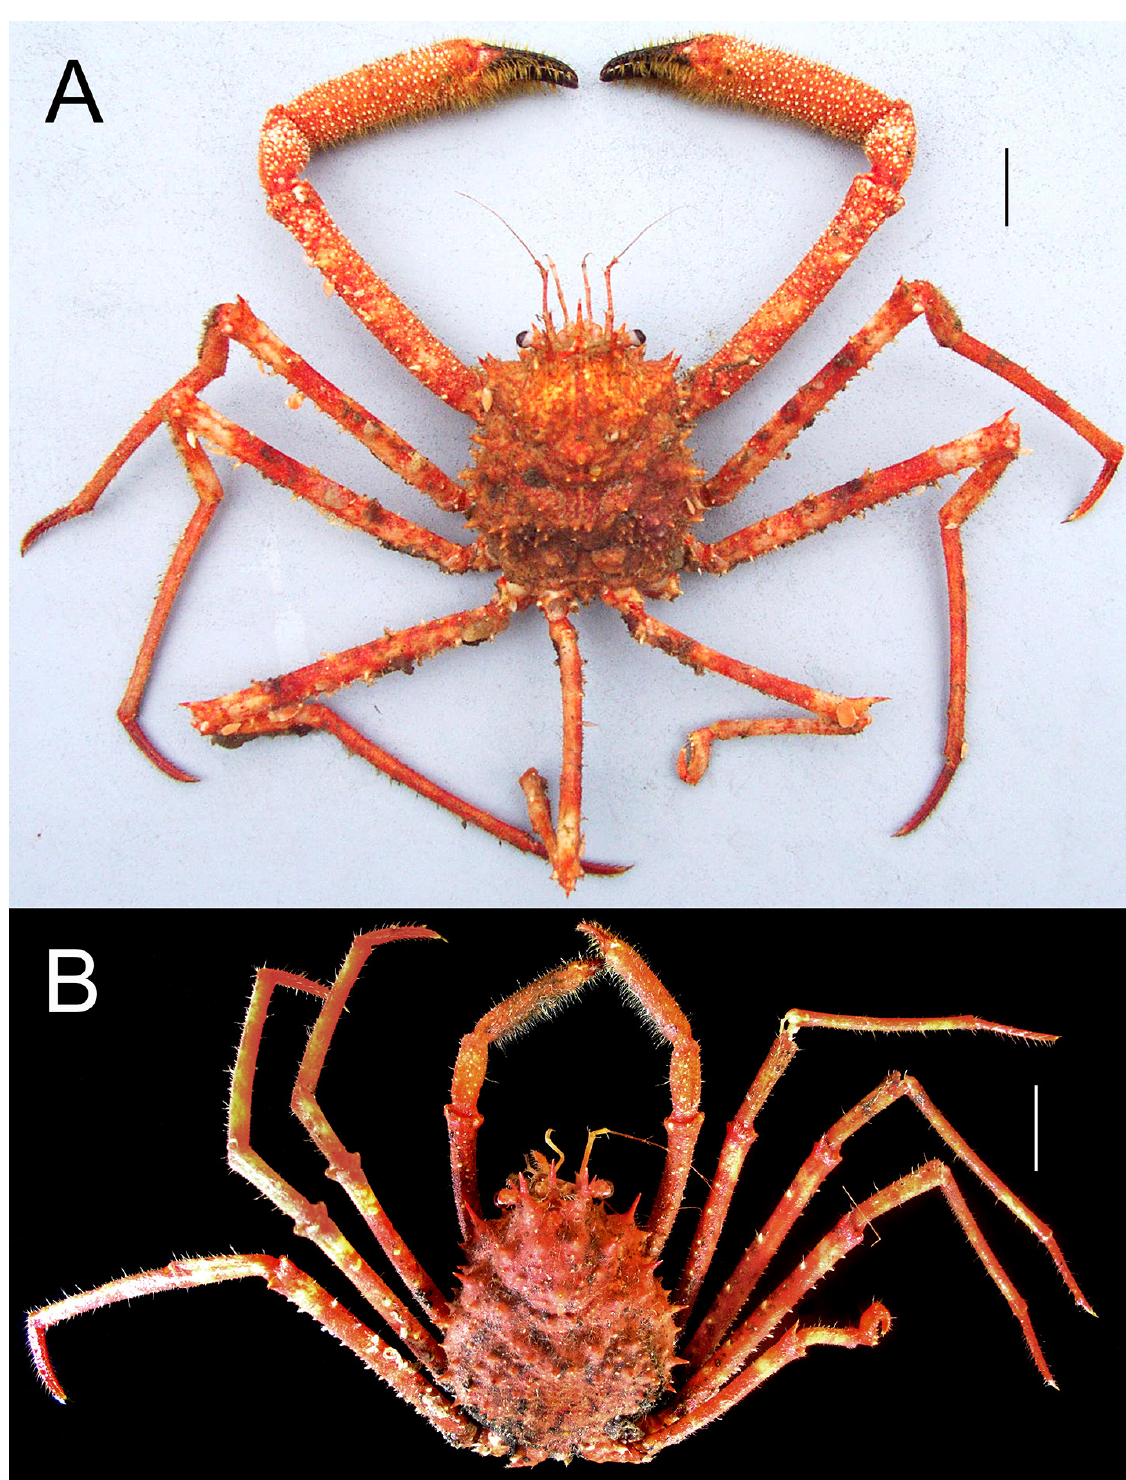
Fig. 17. Colour in life, dorsal view. A . Moloha alisae Guinot & Richer de Forges, 1995. ♂ (cl 67.7 mm, cw 56.2 mm) (ZRC 2008.1250a), South Africa [photograph by Sean Fennessy]. B . Moloha tumida sp. nov. Holotype, ♂ (cl 55.7 mm, cw 50.6 mm) (DABFUK), India [photograph by Biju Kumar]. Scale bars = 20